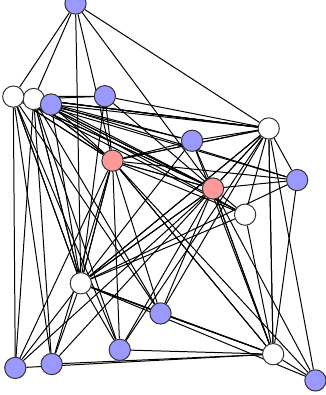
Figure 1. A small network example.